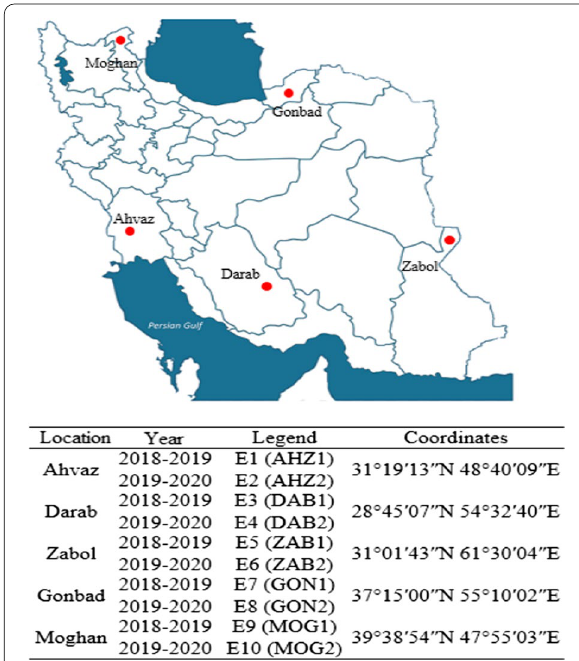
Fig. 1 The geographical distribution and additional information of each test